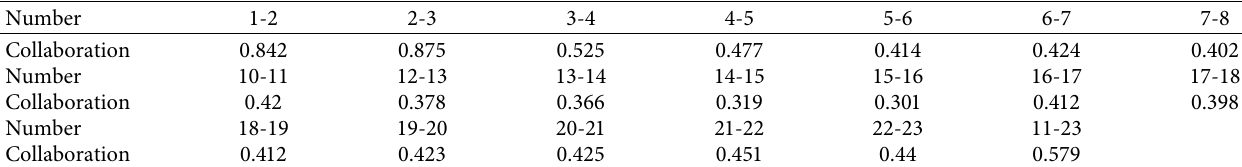
Table 4: Collaboration degree of highway transportation